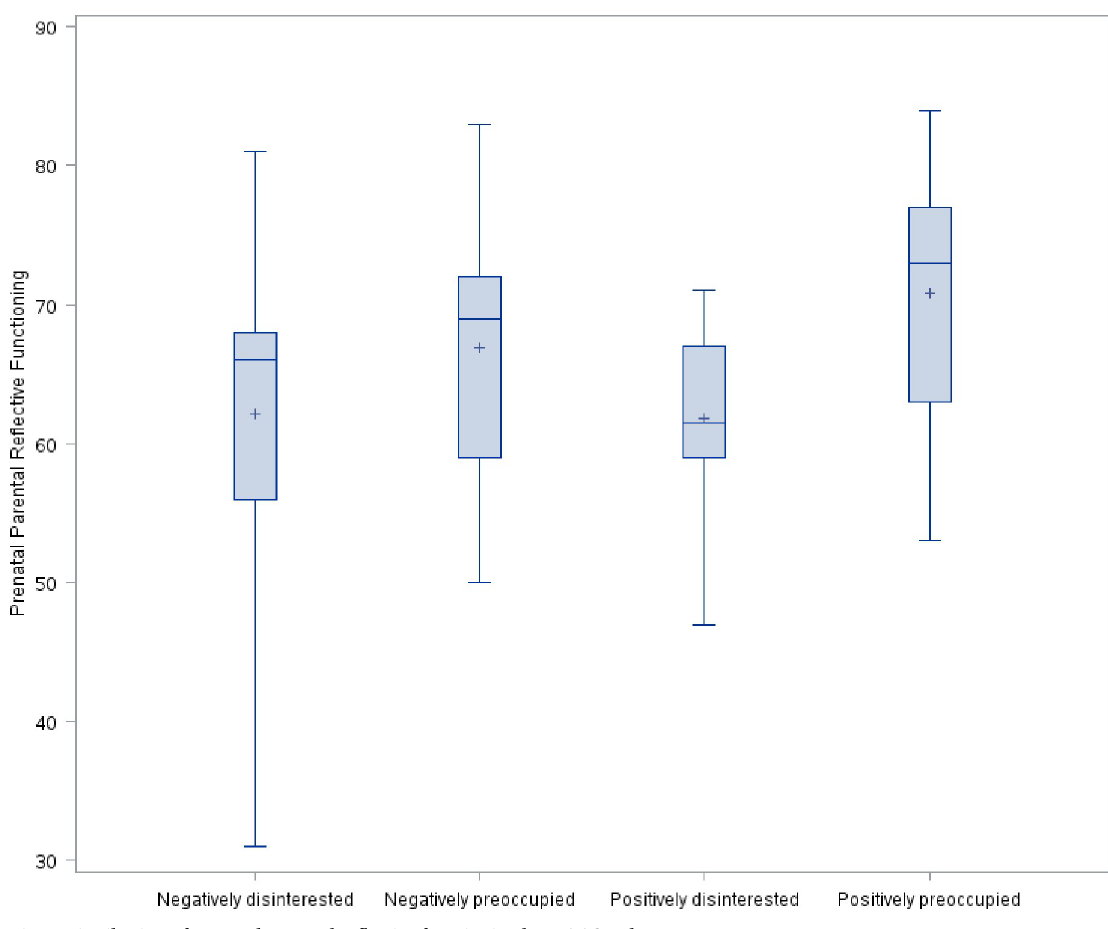
Fig 2. Distribution of prenatal parental reflective functioning by MAAS